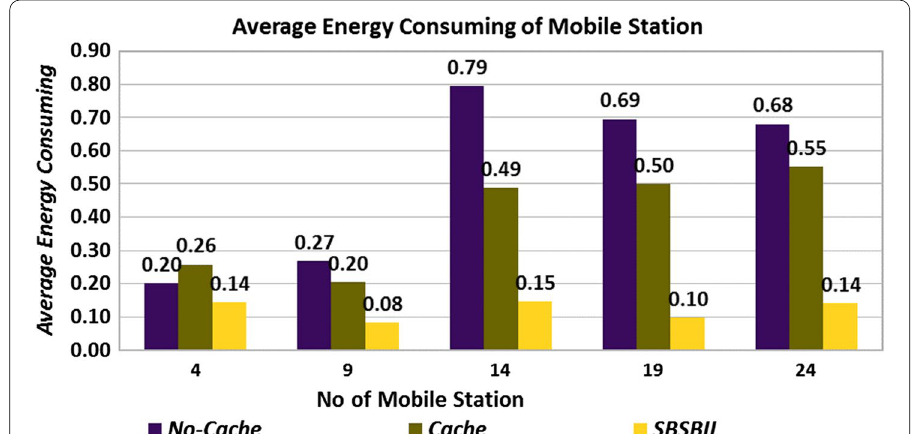
Fig. 4 Average Energy Consuming of MSs comparison between SBS‑no‑cache, SBS‑cache and SBSBIL for different number of MSs